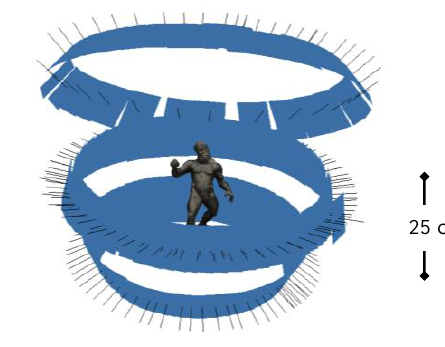
Figure 9. Image block geometry for the bronzes surveys.